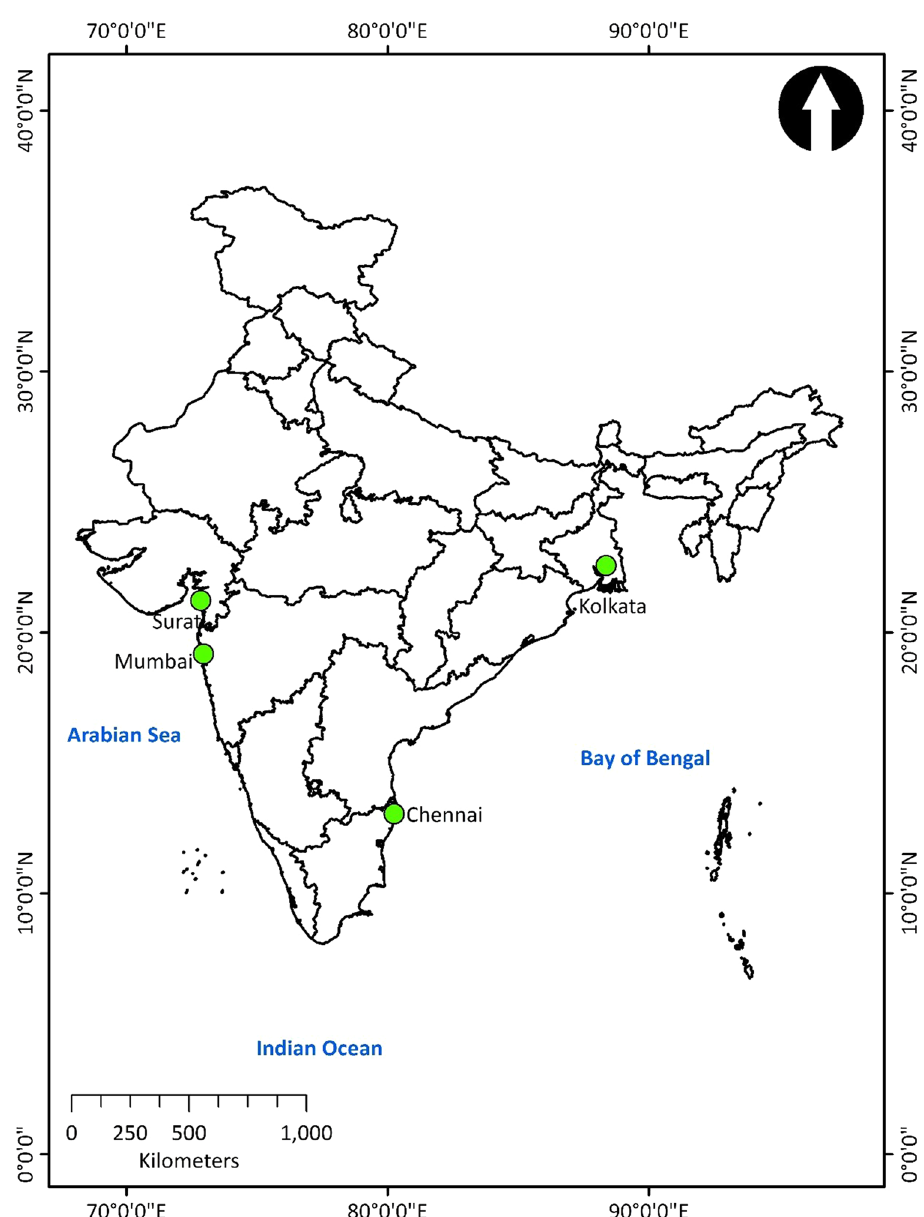
Fig. 1 Locations map of study